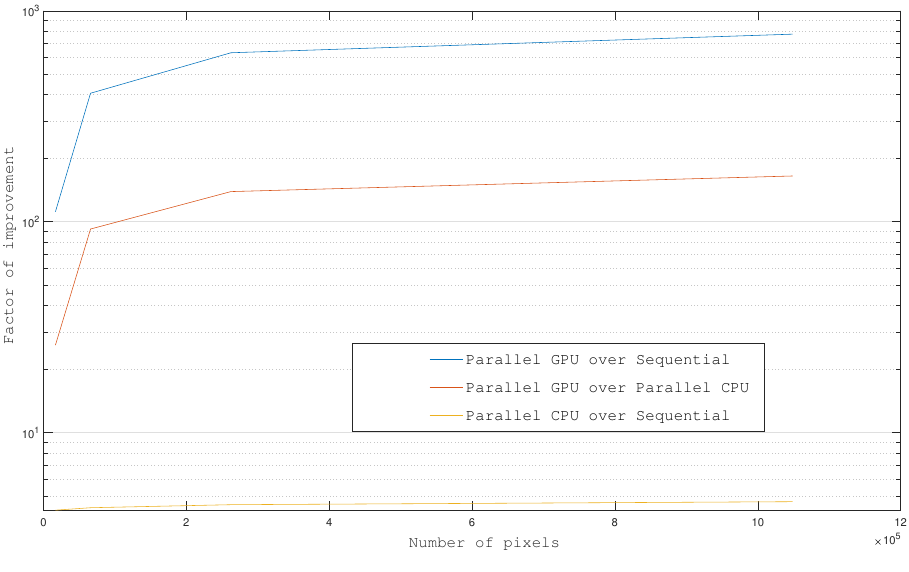
Figure 4. Improvement factors for the three algorithm